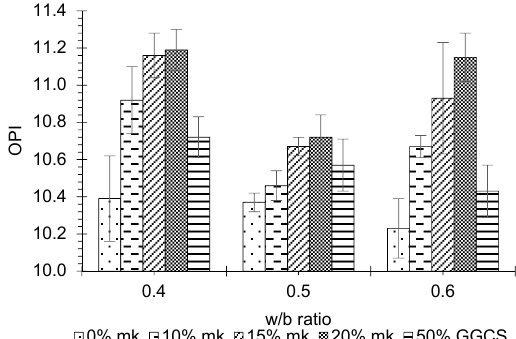
Figure 3. Oxygen Permeability Index (OPI) of concrete at different w/b ratios.